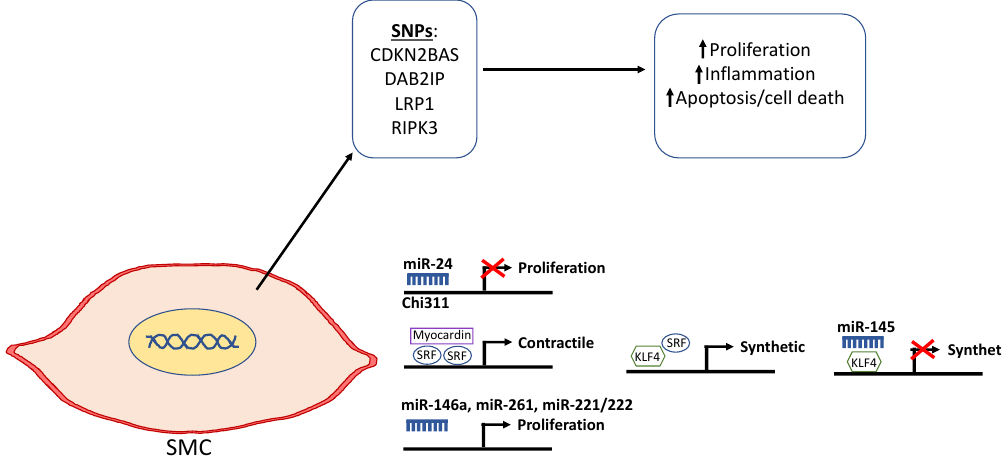
Figure 3. Schematic depicting the genetic and epigenetic mechanisms that are involved in the phenotypic modulation of smooth muscle cells (SMCs) in AAA. Single nucleotide polymorphisms in selected genes including cyclin dependent kinase 2B antisense (CDKN2BAS / ANRIL), DAB2IP, lipoprotein receptor-related protein 1 (LRP1), and receptor-interacting serine / threonine-protein kinase 3 (RIPK3) have been shown to be associated with the diseased SMC phenotype as depicted by increased proliferation that leads to vascular remodeling, inflammation, and cell death. miR-24 selectively targets Chi311 to inhibit proliferation. Kruppel-like factor 4 (KLF4) normally represses myocardin to downregulate SMC differentiation and promote the synthetic phenotype. miR-145 can repress KLF4 and, in turn, inhibit de-differentiation into the synthetic SMC phenotype. miR-146a, miR-261, and mir-221 / 222 have been reported to promote SMC